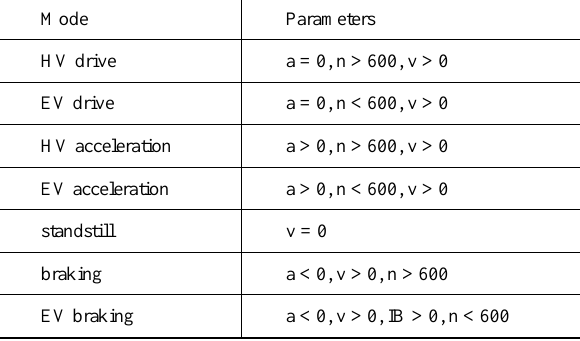
Table 3. Criteria for determining individual modes during the test Mode Parameters